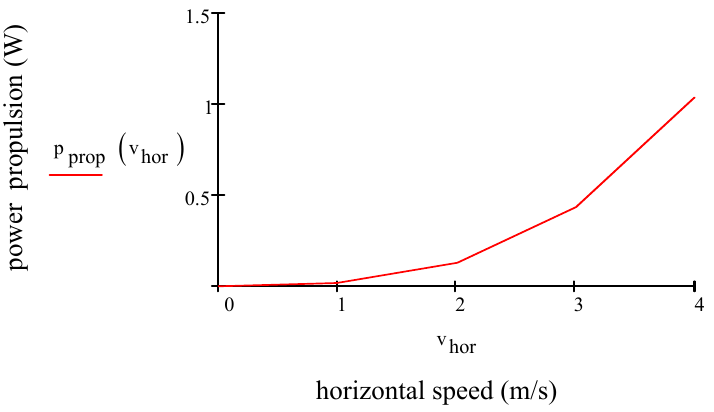
Figure 4. Electric power consumption for one motor vs. horizontal speed.